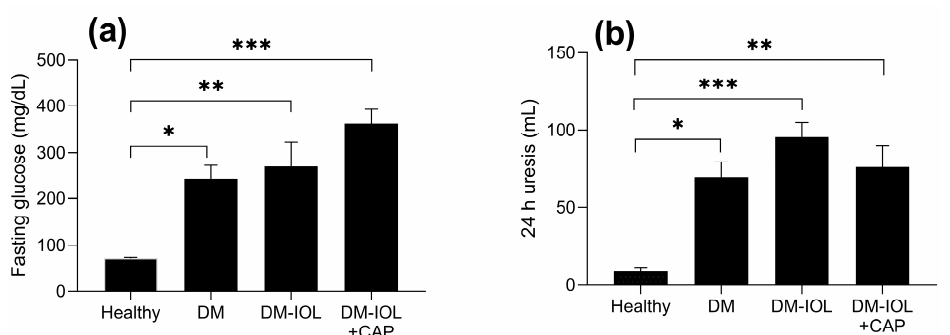
Figure 1. Effects of capsaicin (CAP) on ( a ) glucose and ( b ) uresis in diabetic (DM) rats with iron overload (IOL). There was no statistical difference ( p > 0.05) between the DM groups. Data are expressed as the mean ± standard error. ANOVA and post-hoc Bonferroni test. DM: DM without IOL; DMIOL: DM and 12 weeks IOL; DM-IOL + CAP: DM and 12 weeks IOL + CAP. * p ≤ 0.05, ** p ≤ 0.01, *** p ≤ 0.001.